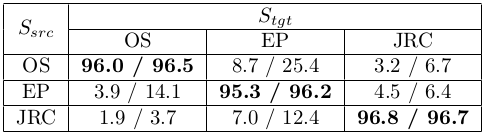
Table from the paper: Monolingual and Cross-lingual Zero-shot Style Transfer
Table text:
S src
S tgt
OS
EP
JRC
OS
96.0/96.5
8.7/25.4
3.2/6.7
EP
3.9/14.1
95.3/96.2
4.5/6.4
JRC
1.9/3.7
7.0/12.4
96.8/96.7